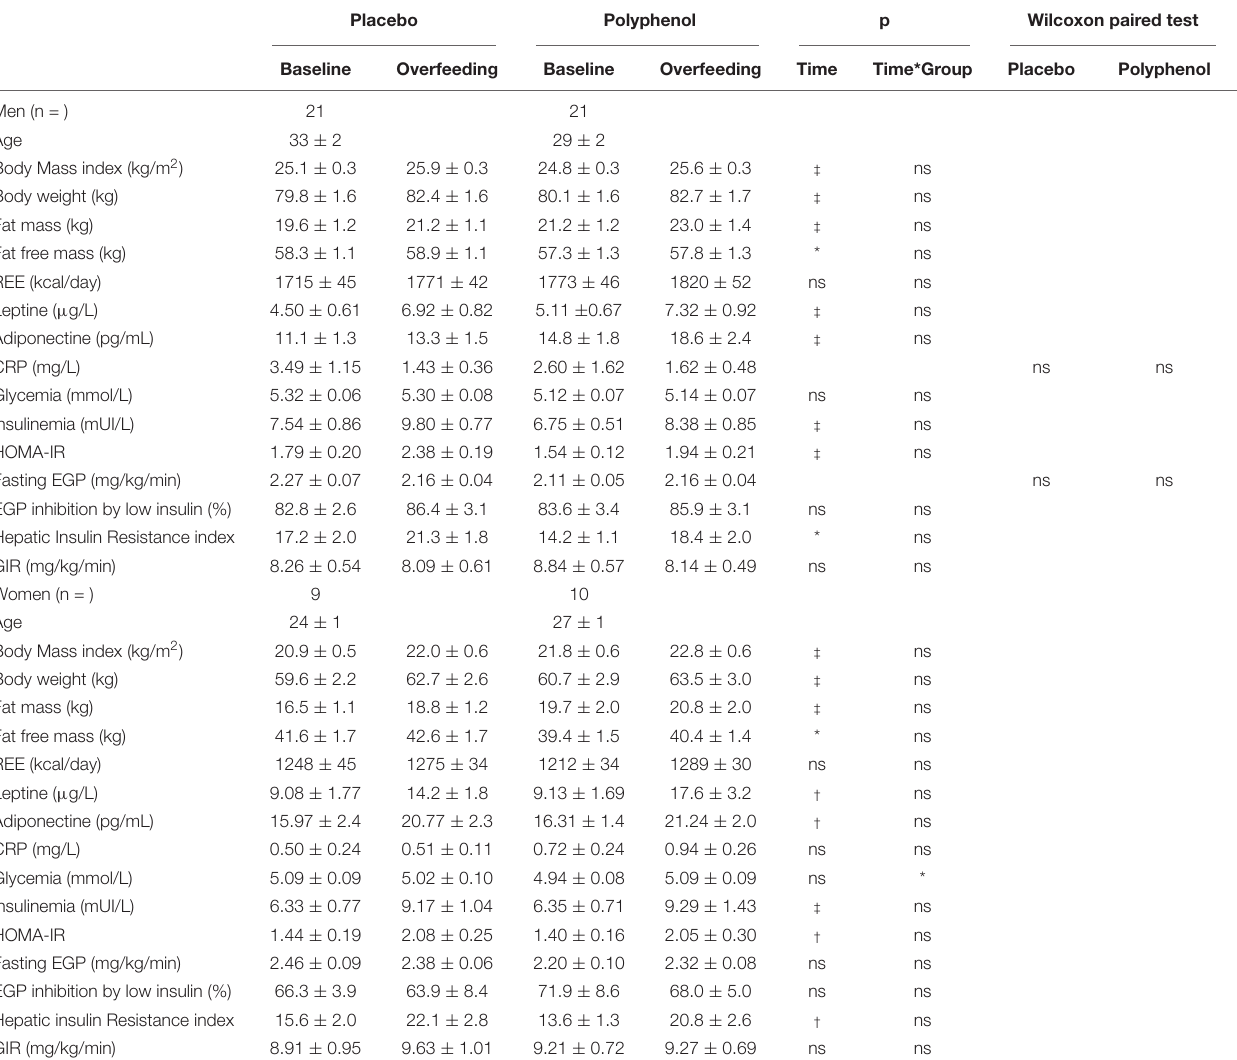
TABLE 1 | Body composition, resting energy expenditure (REE), leptin, adiponectin, C-reactive protein (CRP), fasting glycemia, insulinemia, homeostasis model assessment of insulin resistance (HOMA-IR) and euglycemic hyperinsulinic clamp parameters of the male cohort and female cohort before and after overfeeding. Placebo Polyphenol p Wilcoxon paired test Baseline Overfeeding Baseline Overfeeding Time Time*Group Placebo